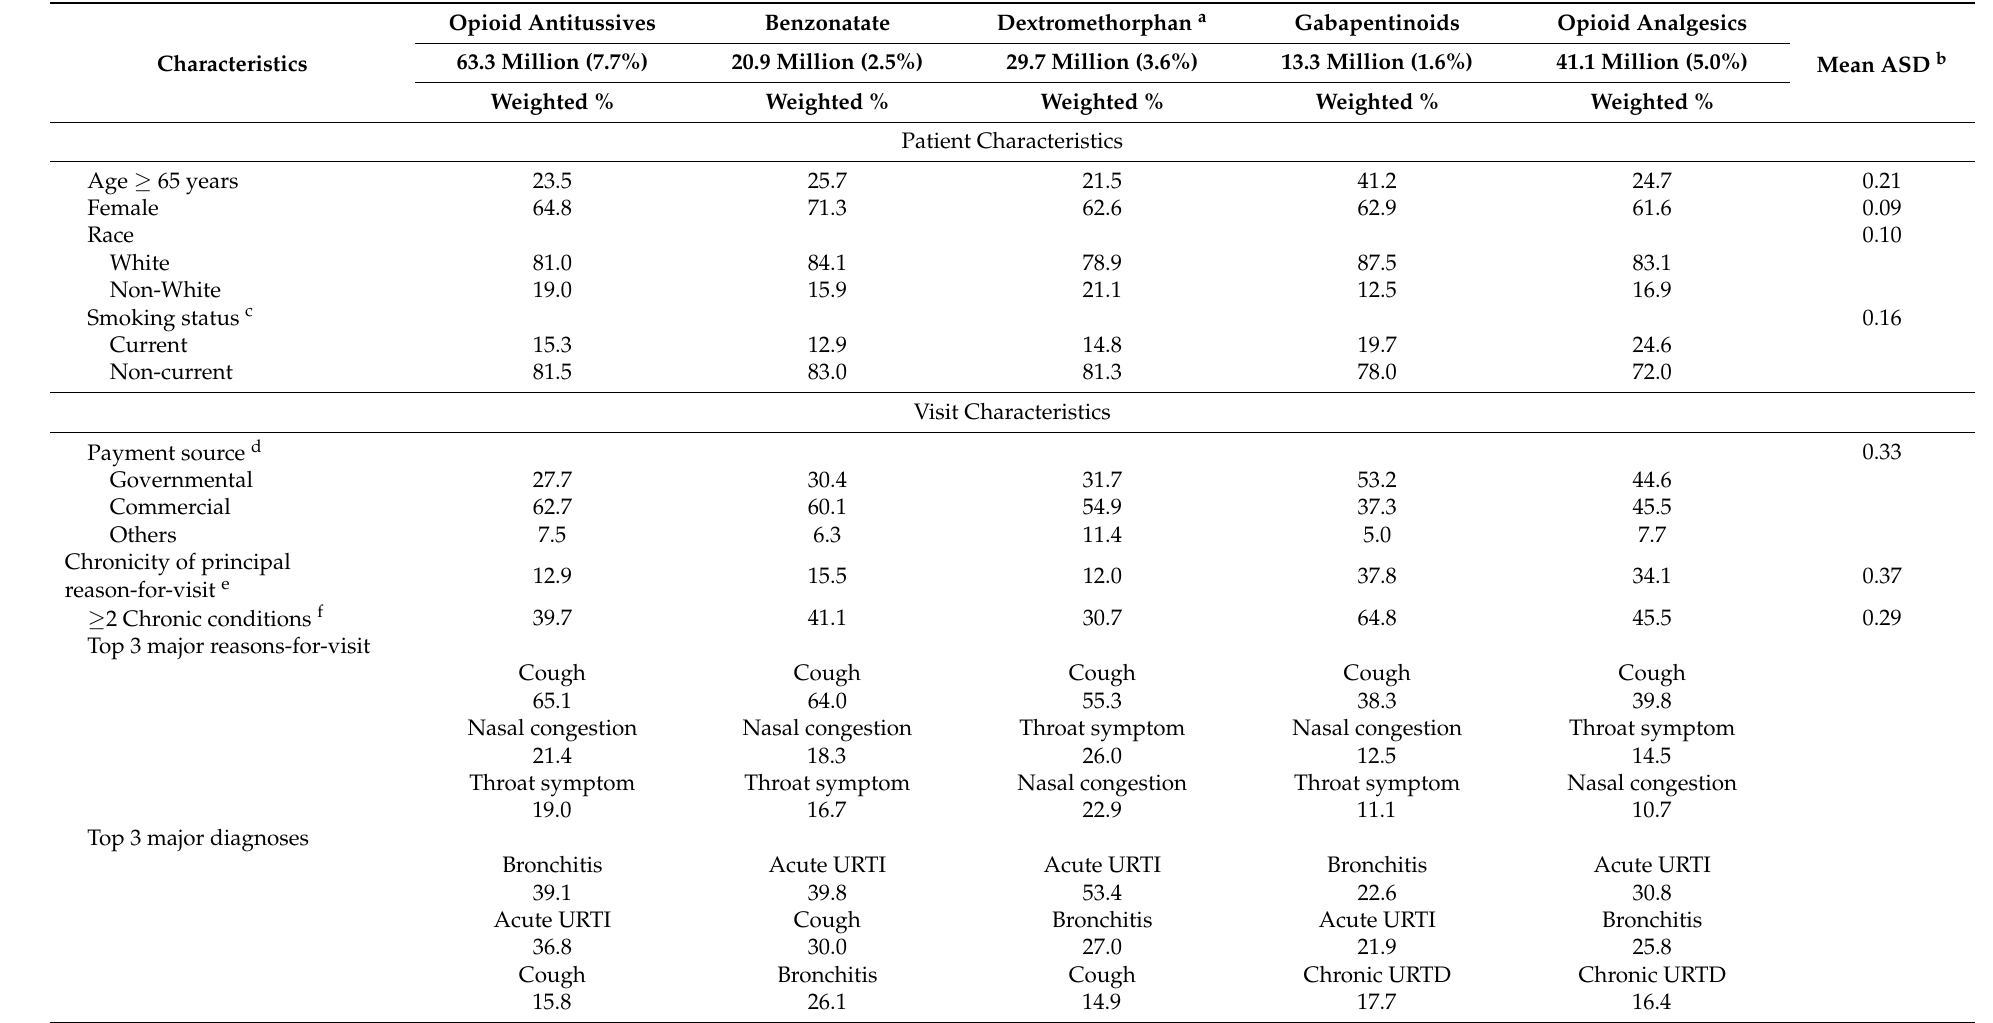
Table 1. Patient, visit, and practice characteristics of adult cough-related office-based visits by medication type: 2003–2018 NAMCS (weighted-estimate of 819.9